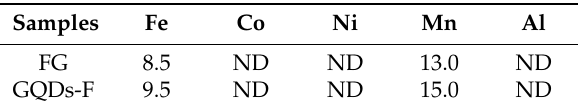
Table 2. The contents of the metal impurity elements of FG and GQDs-F measured by the ICP spectrometry. The unit is ppm, and ‘ND’ denotes ‘not found’.